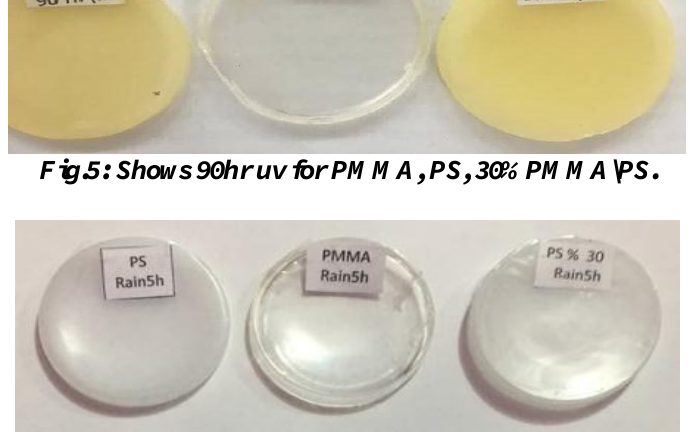
Fig.6: Shows 5hr rain for PMMA, PS, 30%PMMA\PS.